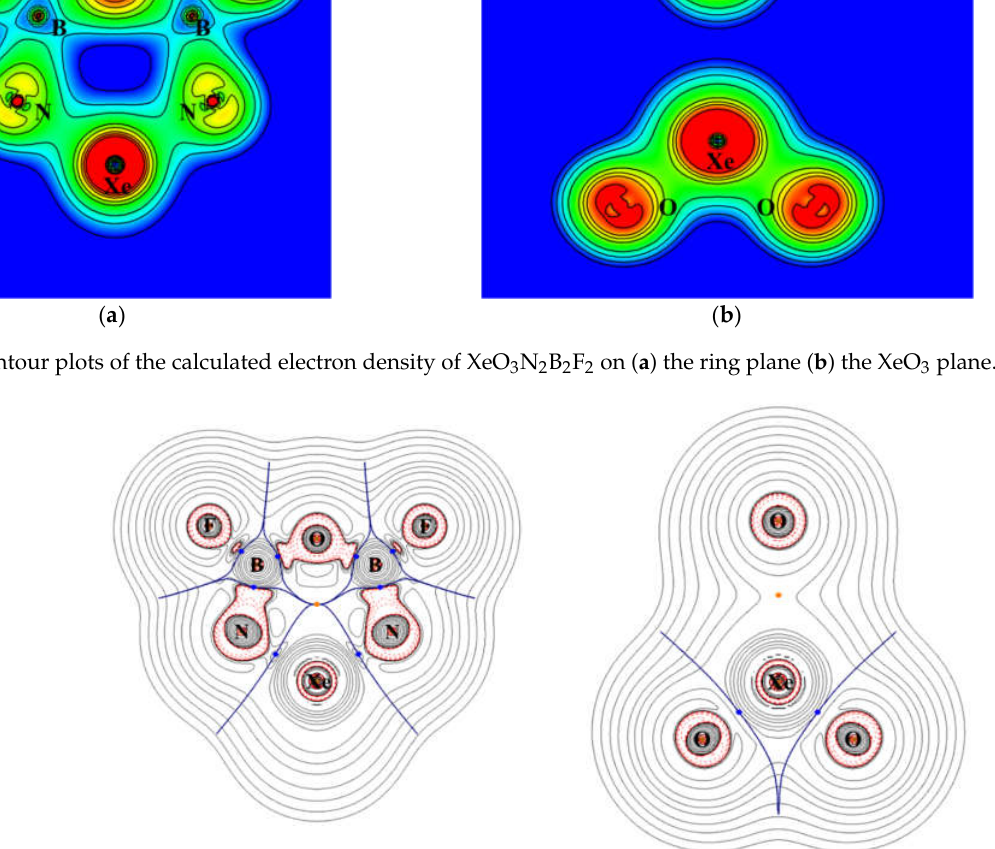
Figure 6. Contour plots of the calculated electron density of XeO 3 N 2 B 2 F 2 on ( a ) the ring plane ( b ) the XeO 3 plane.